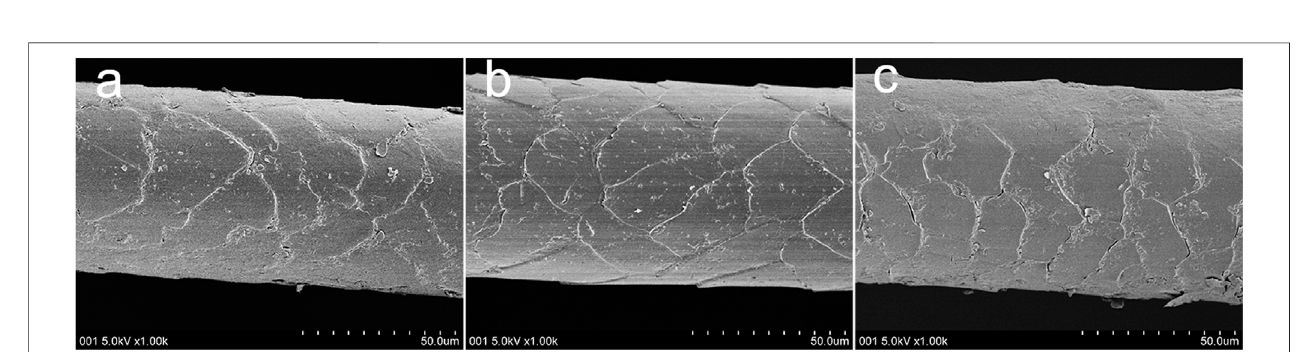
FIGURE 3 | Polar bear hair surface structure by FE-SEM (A-C) different locations on the hair surface.